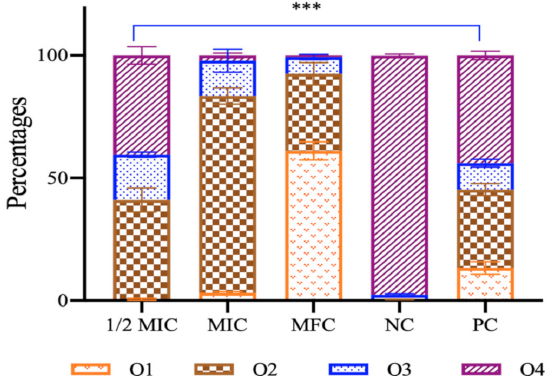
Figure 8. Phosphatidylserine exposure in C. auris. Cells were exposed to 0.19 µ g/mL ( 1 / 2 Mini- mum Inhibitory Concentration - MIC), 0.39 µ g/mL (MIC) and 0.78 µ g/mL (Minimum Fungicidal concentration—MFC) of Ag–Fe NPs. NC represents untreated negative control and PC represents H 2 O 2 treated positive control. *** p ≤